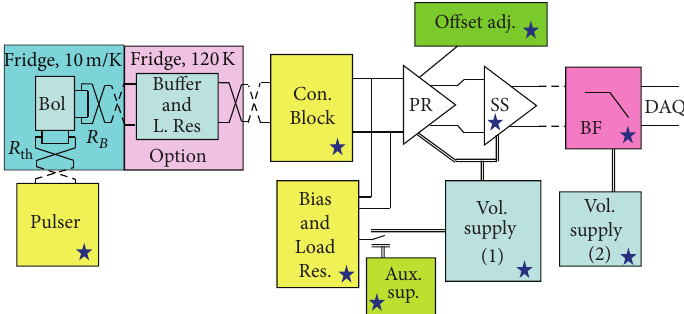
Figure 2: Schematic diagram of the electronics system of LUCIFER. Stars on the blocks denote the presence of remote programmability.